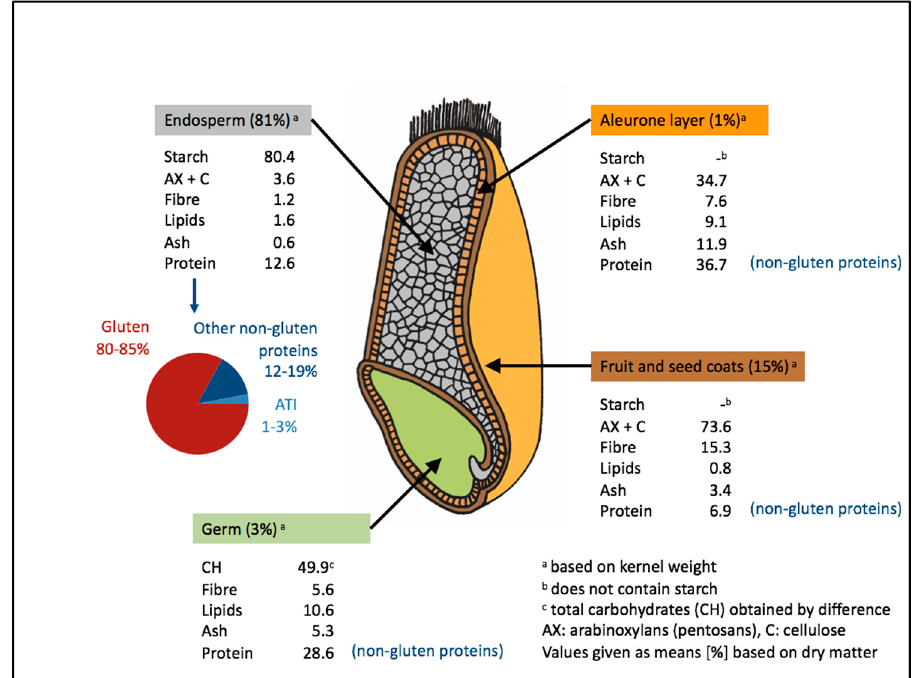
Figure 2. Wheat components. Figure 2. Wheat